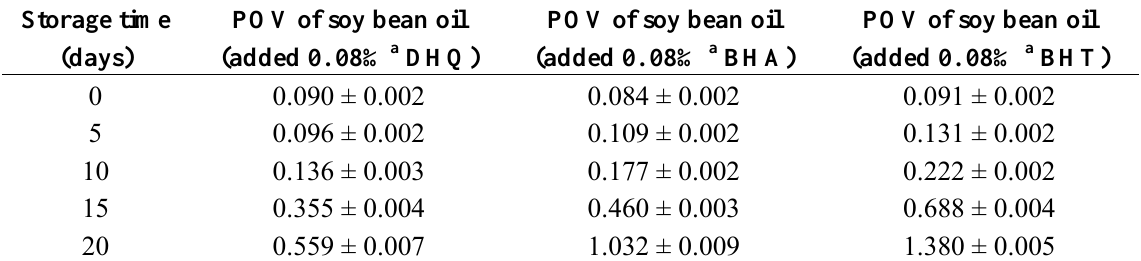
Table 5. POV of soy bean oil after addition of synthetic antioxidants during storage at 60 °C. Storage